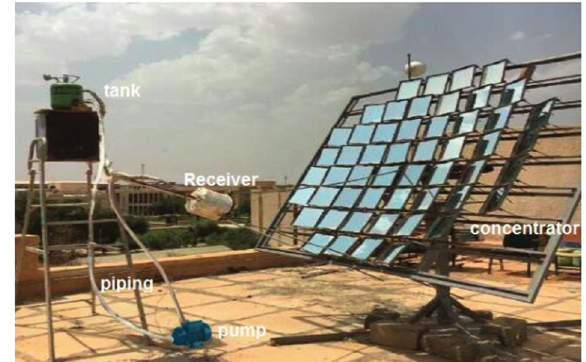
Figure 6: Solar dish component system.